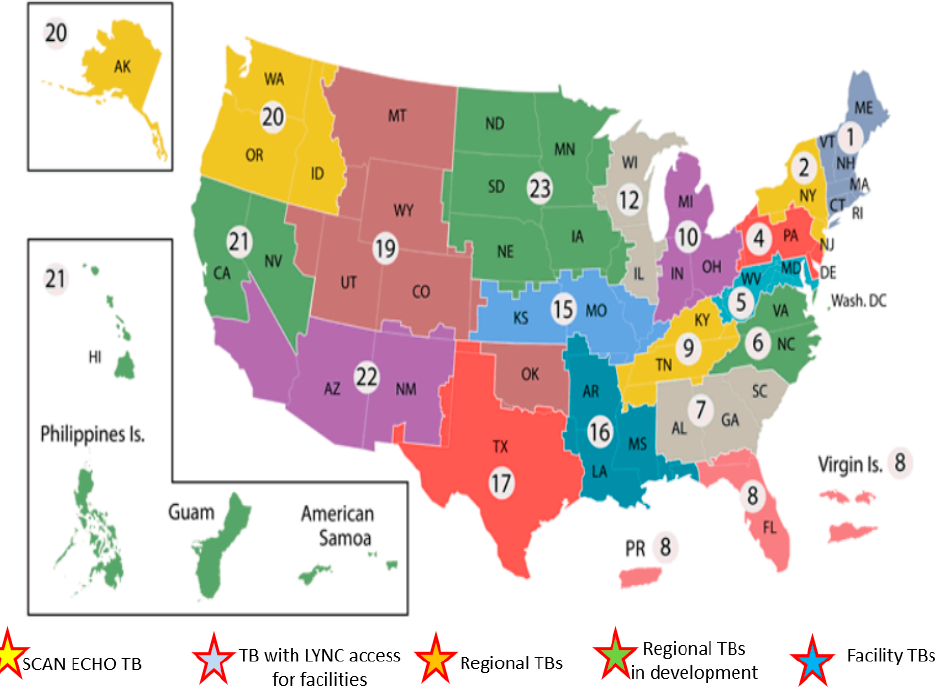
Figure 3. Current state of regional and local liver cance tumor boards in Veterans hospital across the US.